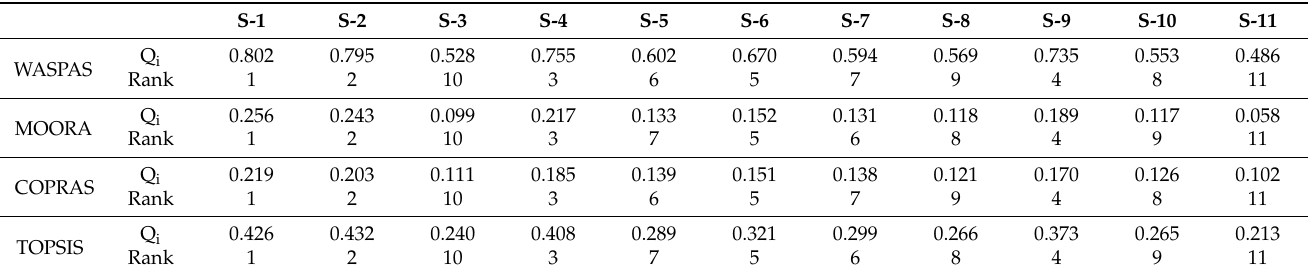
Table 4. Ranking of candidate sites through WASPAS, MOORA, COPRAS, and